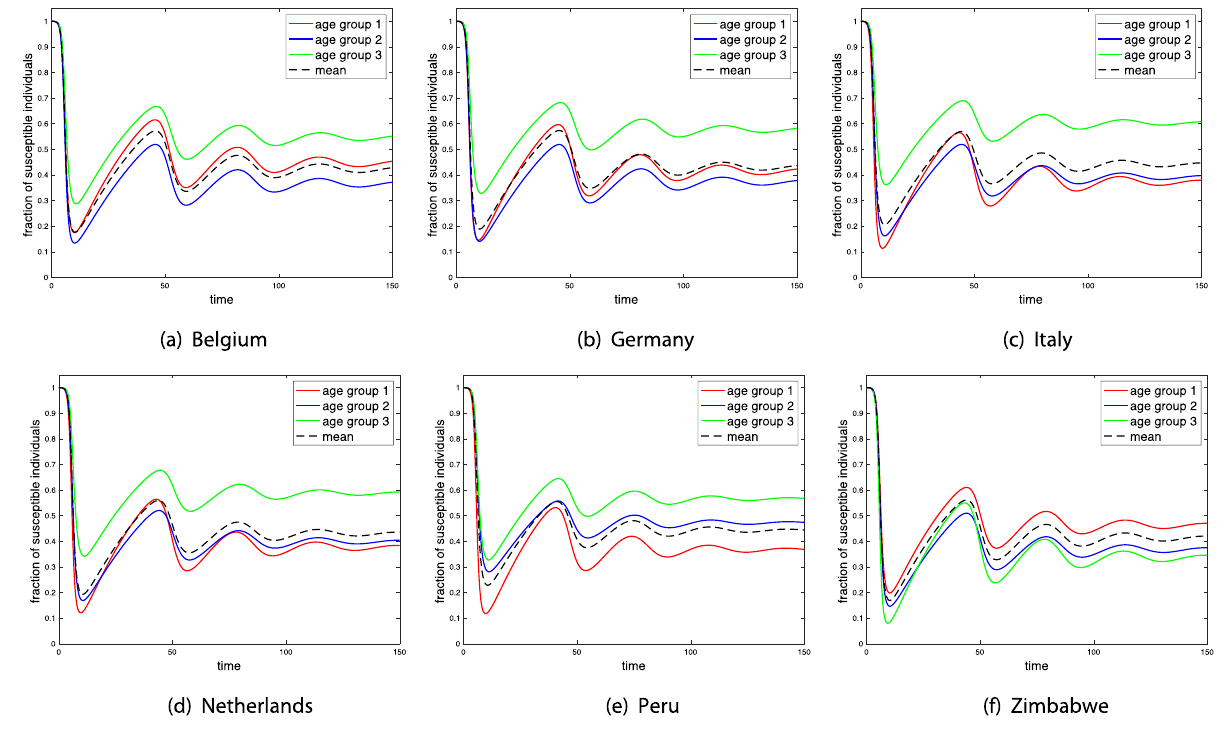
Figure 2. Examples of evolution of susceptible individuals during an epidemic given by (1) without vaccination with initial condition ( s i ( 0 ) , y i ( 0 ) , r i ( 0 )) = ( 0.9999, 0.0001, 0 ) for i = 1, 2, 3 . Parameters: γ 1 = 1 , γ 2 = 1 , γ 3 = 0.9 , δ 1 = 1 / 40 , δ 2 = 1 / 52 , and δ 3 = 1 / 40 . For each country, β is scaled such that R 0 = 2.5 for the corresponding data set in the absence of vaccinated individuals. Data